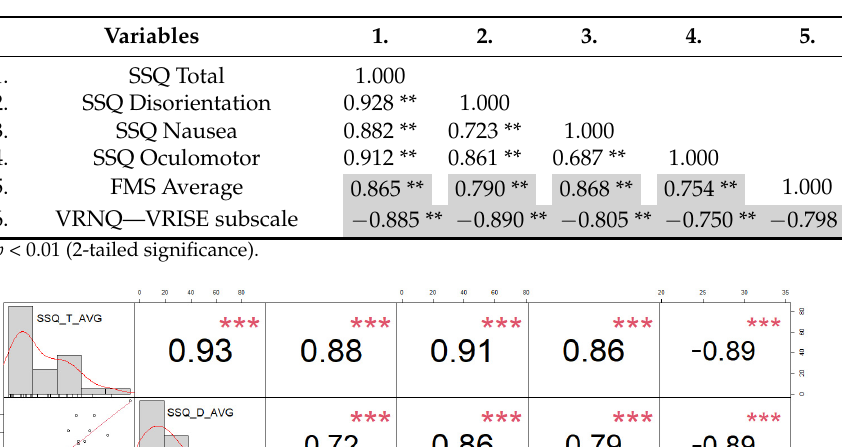
Table 11. Correlation matrix for average VRISE scores—spearman ( ρ ) correlation coefficients for combined measures ( n = 6).